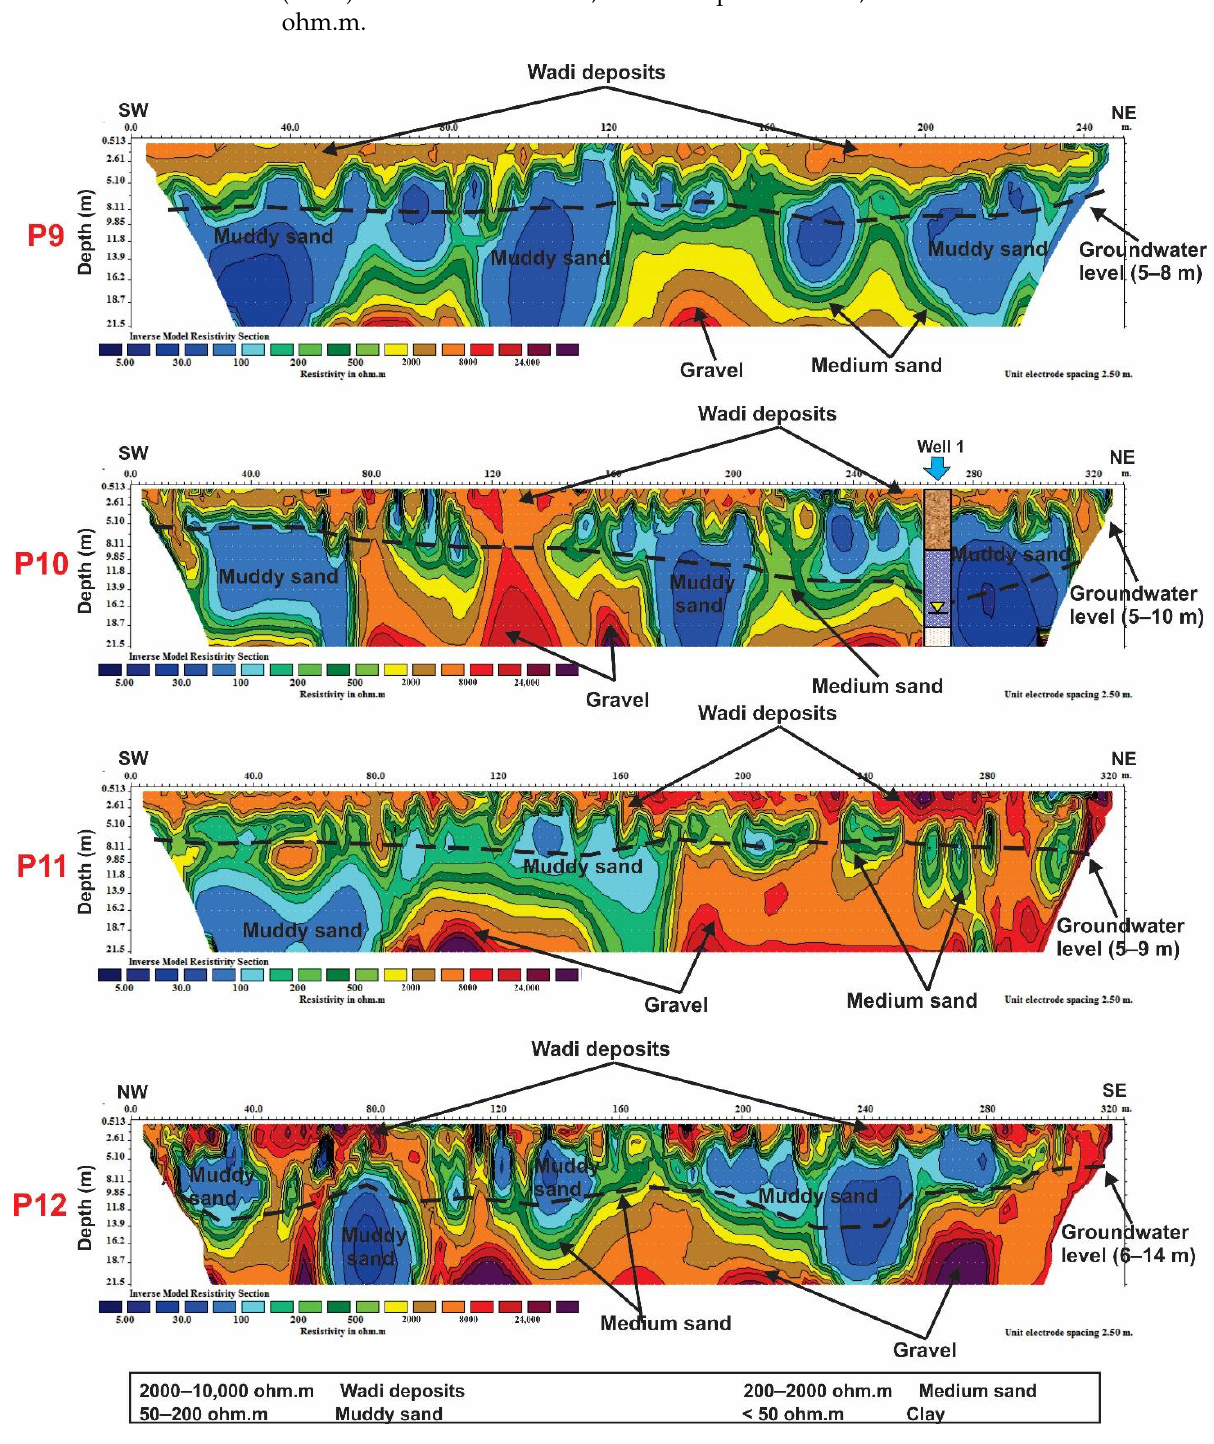
Figure 7. Interpreted 2D inverted resistivity model of profiles 9 – 12. According to the resistivity values, four difference geoelectric zones were recognized. These zones are: (1) wadi deposits, which are mainly composed of gravels, sands, and silts; (2) medium sand deposits; (3) muddy sand deposits; and (4) clay deposits.